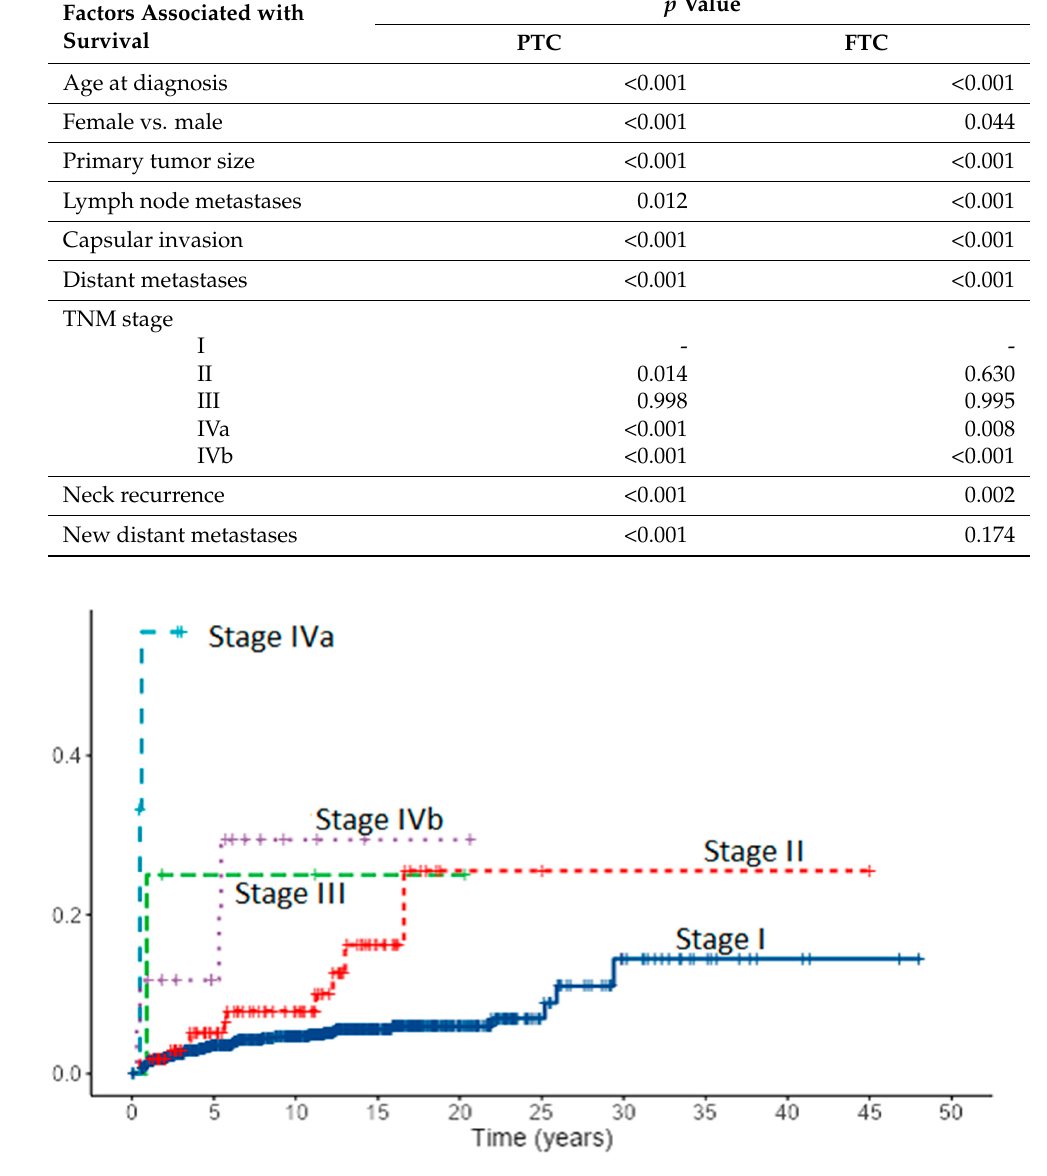
Figure 7. Cumulative events for local recurrence in 1167 patients with PTC by the AJCC/UICC TNM staging system (8th edition).